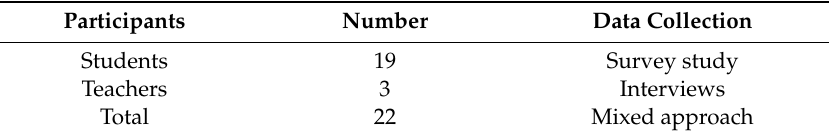
Table 2. Participants and data